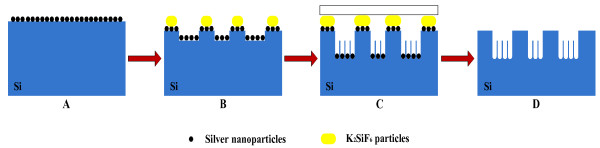
Formation mechanism of MP and NW arrays through the one-step etching in HF/AgNO3/KMnO4solution.